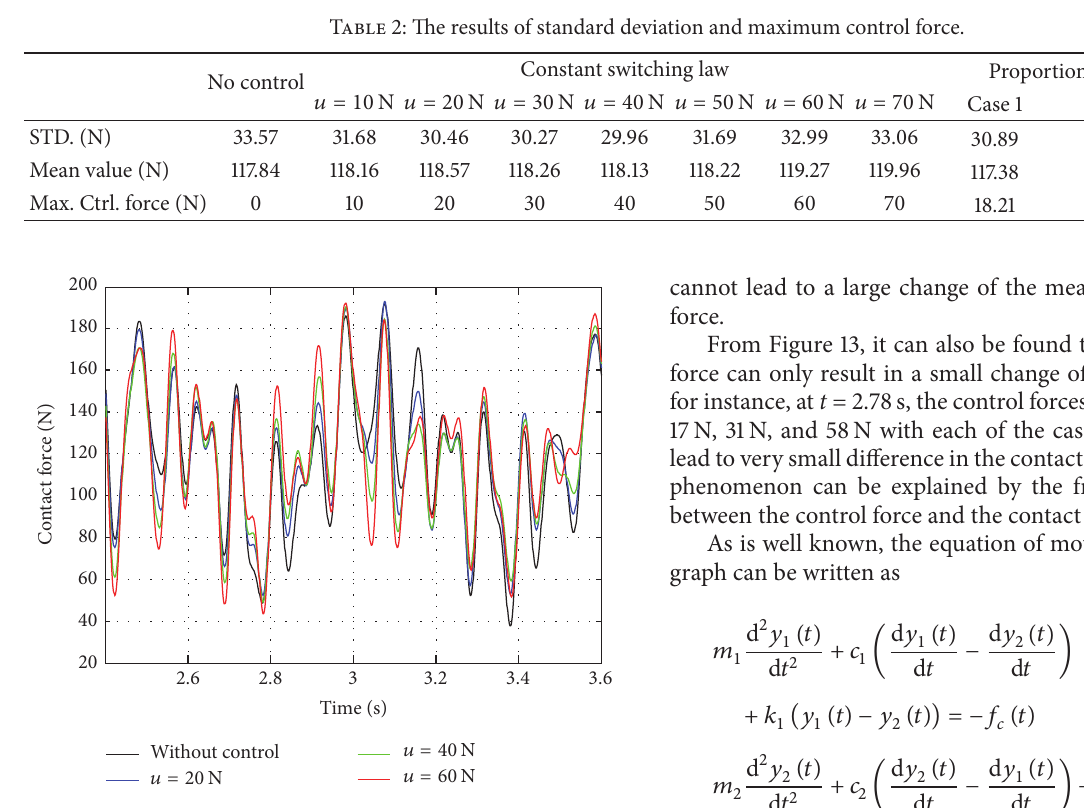
Figure 12: Contact force with constant switching